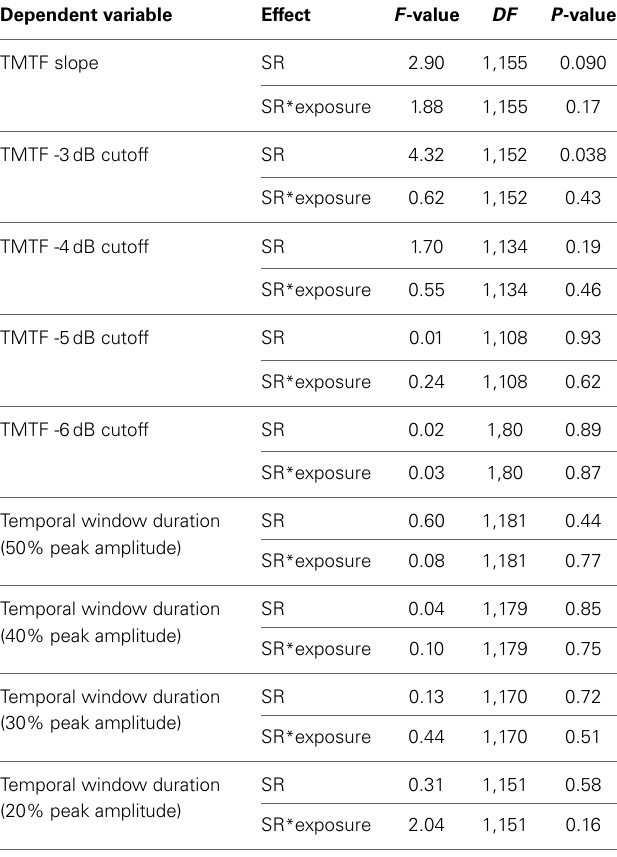
Table 1 | Statistical tests for effects of SR group on temporal precision.